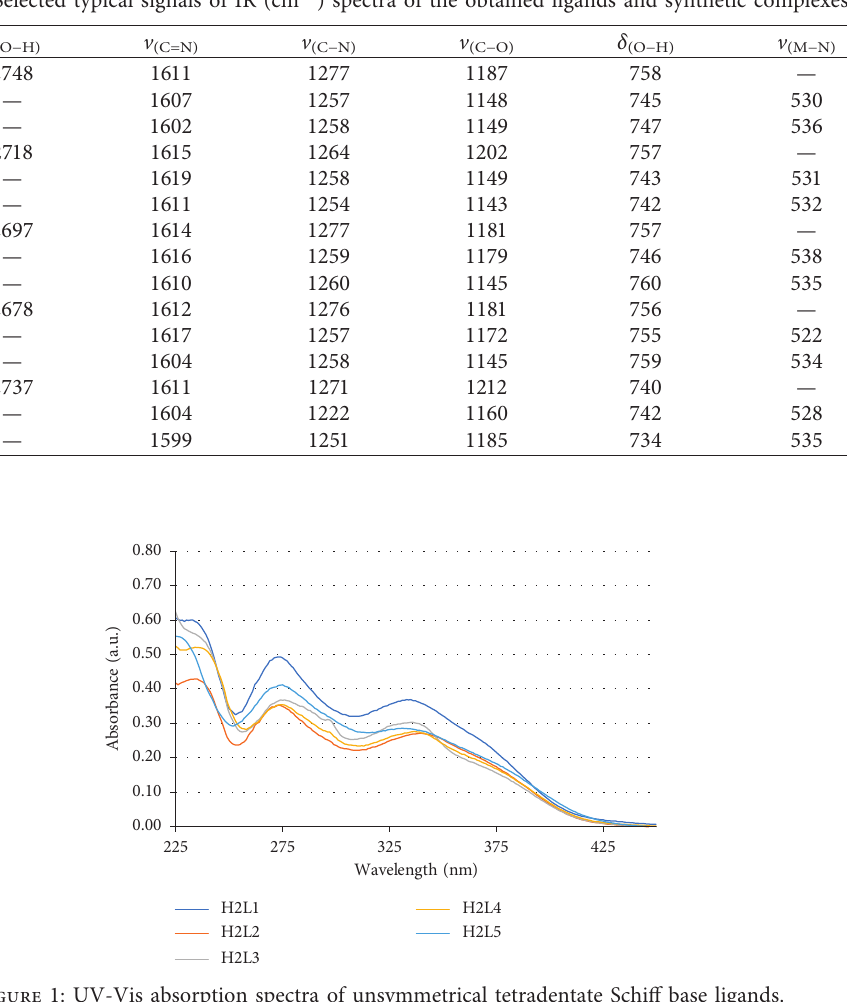
Table 3: Selected typical signals of IR (cm − 1 ) spectra of the obtained ligands and synthetic complexes.